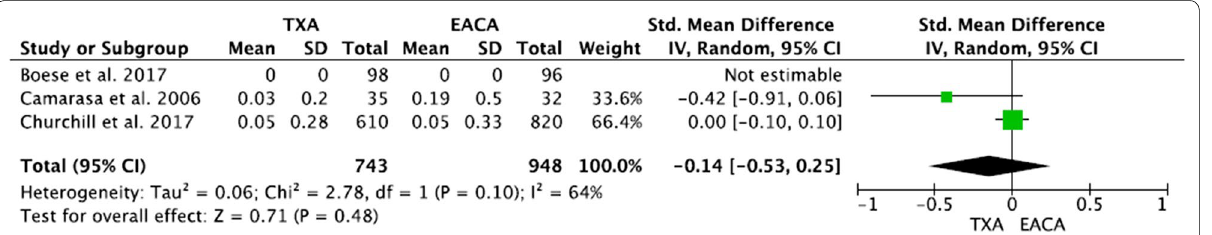
Fig. 5 Average no. of transfused